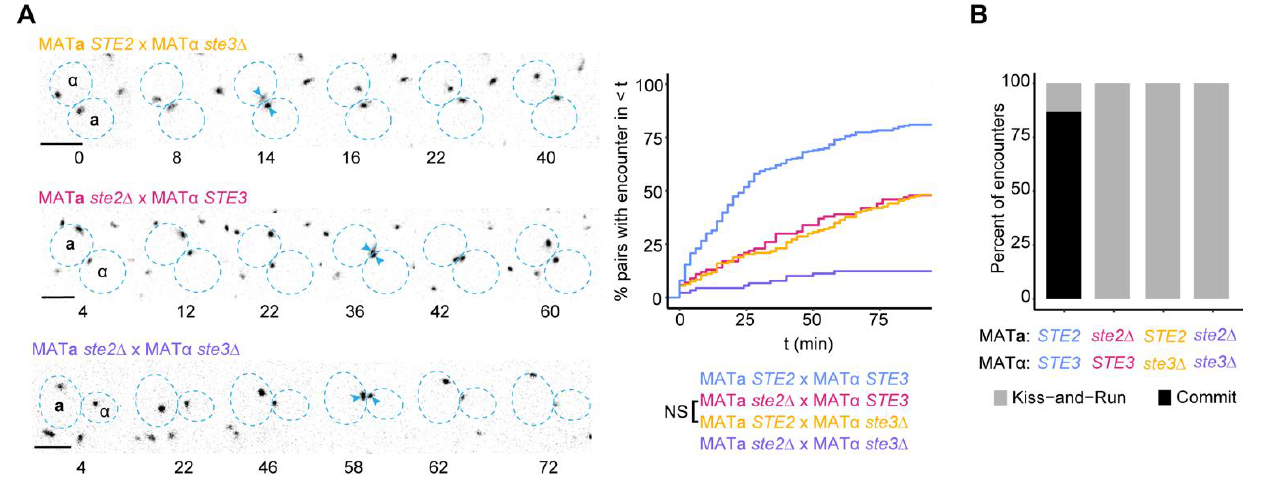
Figure 3. Polarity site encounters when only one partner can sense pheromone. ( A ) Left: Representative inverted maximum projection images of polarity sites labeled with Spa2-mCherry in mating mixes where one or both partners lack pheromone receptors: MAT a STE2 × MAT α ste3 Δ (DLY20626 × DLY23979), MAT a ste2 Δ × MAT α STE3 (DLY23978 × DLY20627), MAT a ste2 Δ × MAT α ste3 Δ (DLY23978 × DLY23979). Blue arrowheads indicate polarity site encounters, dotted blue lines outline each cell. Time is in min. Scale bar, 5 µm. Right: Cumulative distributions of the time to polarity site encounter in the same mating mixes ( n ≥ 89 pairs) (NS = KS test p > 0.05). ( B ) Percent of encounters that result in commitment or kiss-and-run ( n ≥ 14 encounters) from the indicated mating mixes.